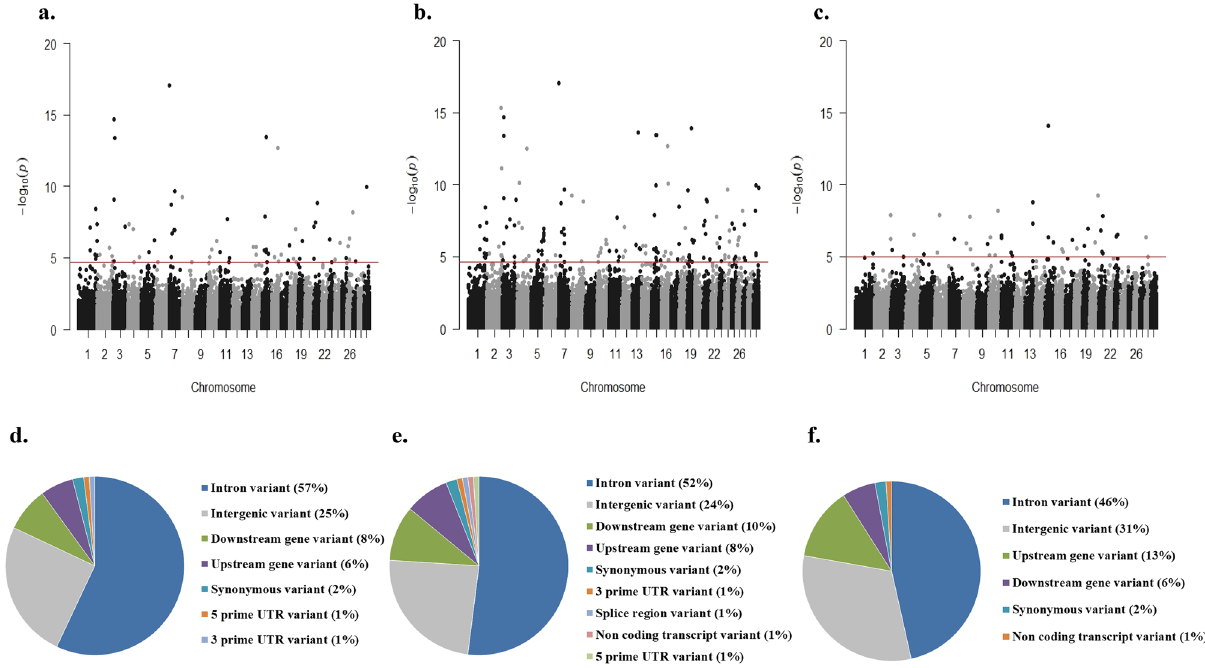
Figure 2. cis -eQTL analysis. ( a , b ) PB cis -eQTLs identified within 0.5 ( a ) and 1 Mb ( b ) upstream of a TSS. ( c ) ICV cis -eQTLs identified within 0.5 Mb upstream of a TSS. The plots show the − log 10 (P-values) of the most significant variants for each of the 24,616 analyzed genes. The red line represents the threshold of P = 2.03E−05 ( a ), P = 2.14E-05 ( b ) and P = 1.02E−05 ( c ). ( d , e ) The chart depicts the genomic distribution of the PB- cis -eQTLs identified within 0.5 ( d ) and 1 Mb ( e ) upstream a TSS according to the Ensembl Variant Effect Predictor (VEP). ( f ) Genomic distribution of the ICV cis -eQTLs according to the